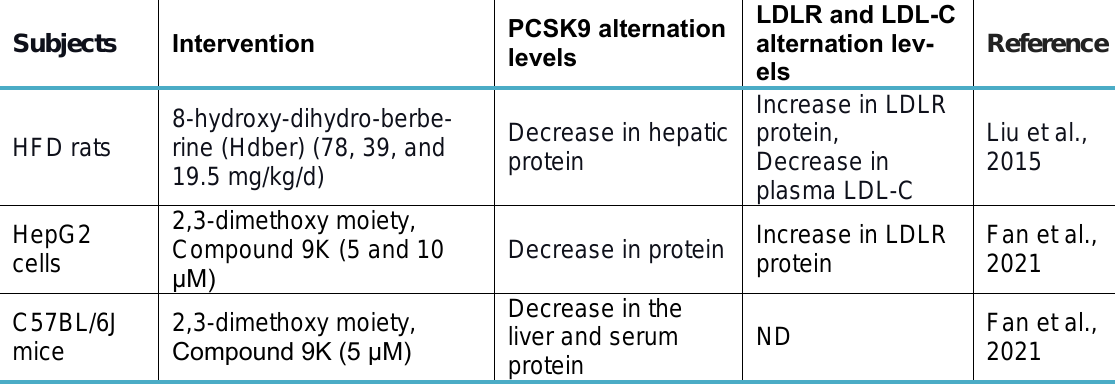
Table 3: Effect of berberine derivatives and modified forms on PCSK9, LDLR, and LDL-C levels in experimental